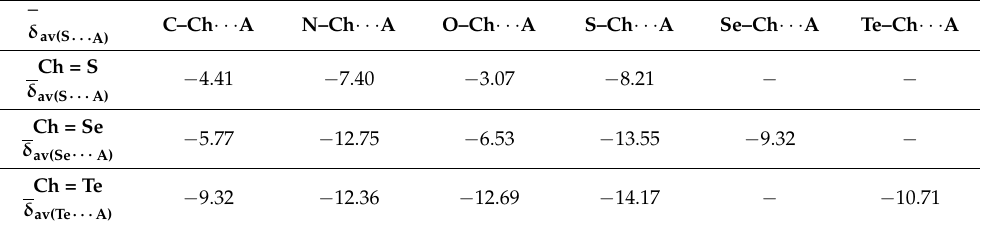
Table 4. Average δ ̅ av(Ch···A) value of the mean δ ̅ Ch···A values calculated for all the A acceptors in the